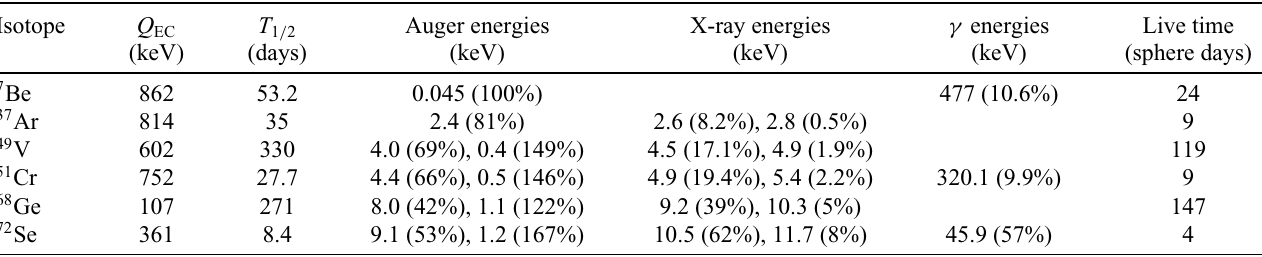
TABLE I. Selected EC isotopes of interest for heavy-neutrino-mass searches between approximately 0.1 and 1 MeV. The Q EC value for the decay and half-life are listed for each candidate, along with the energies and intensities (i.e., the percentage of primary decays of the parent nucleus for which a given secondary particle is emitted) of the secondary Auger e − , x rays, or for γ from decays to nuclear excited states. The live time required to observe 10 4 events (in number of nanospheres × days) assuming 100-nm-diameter SiO 2 nanospheres with 1% loading by mass for each isotope, 40% detection efficiency for the secondary particles, and the detector parameters described in the text, is given in the last column. The isotope data are taken from Ref. [85]. Isotope Q EC T 1 / 2 Auger energies X-ray energies γ energies Live time 7 Be